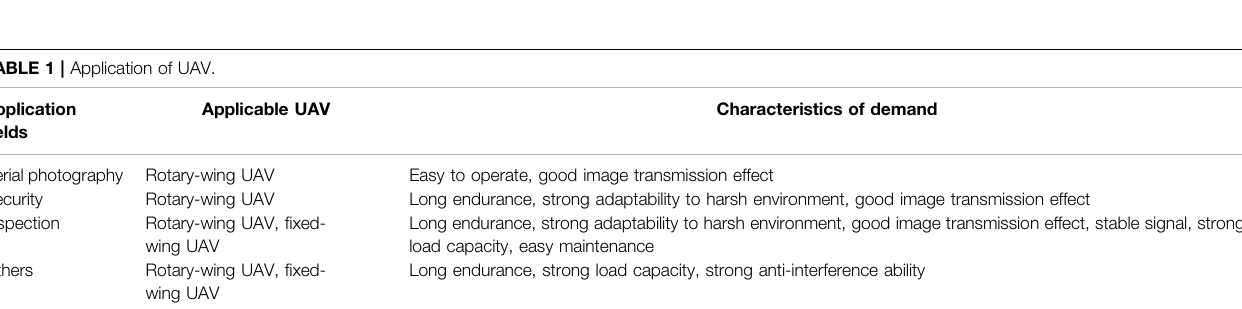
TABLE 1 | Application of